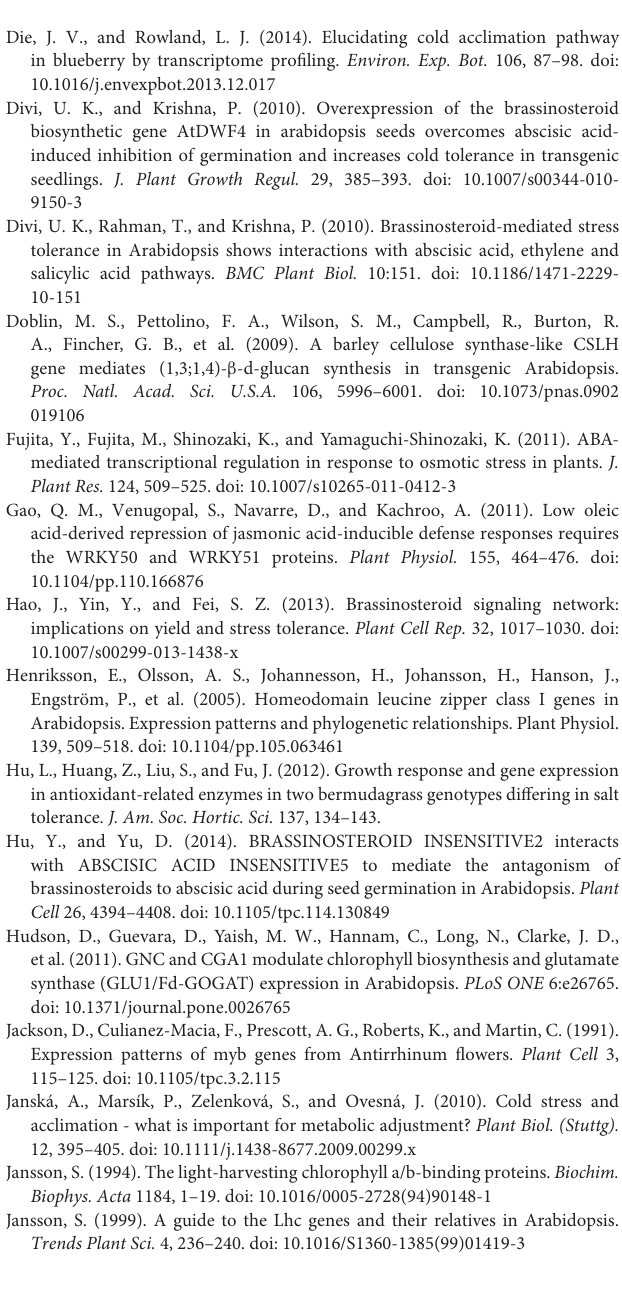
Table S2 | Genes information. Table S3 | RPKM of all genes. Table S4 | Differential expressed genes in chilling stress with EBR-treated plant compared to only chilling treated plant. Table S5 | Gene ontology analyses of differential expressed genes regulated by the EBR + chilling and only chilling stress. Table S6 | KEGG pathway enrichment of differential expressed genes regulated by the EBR + chilling and only chilling